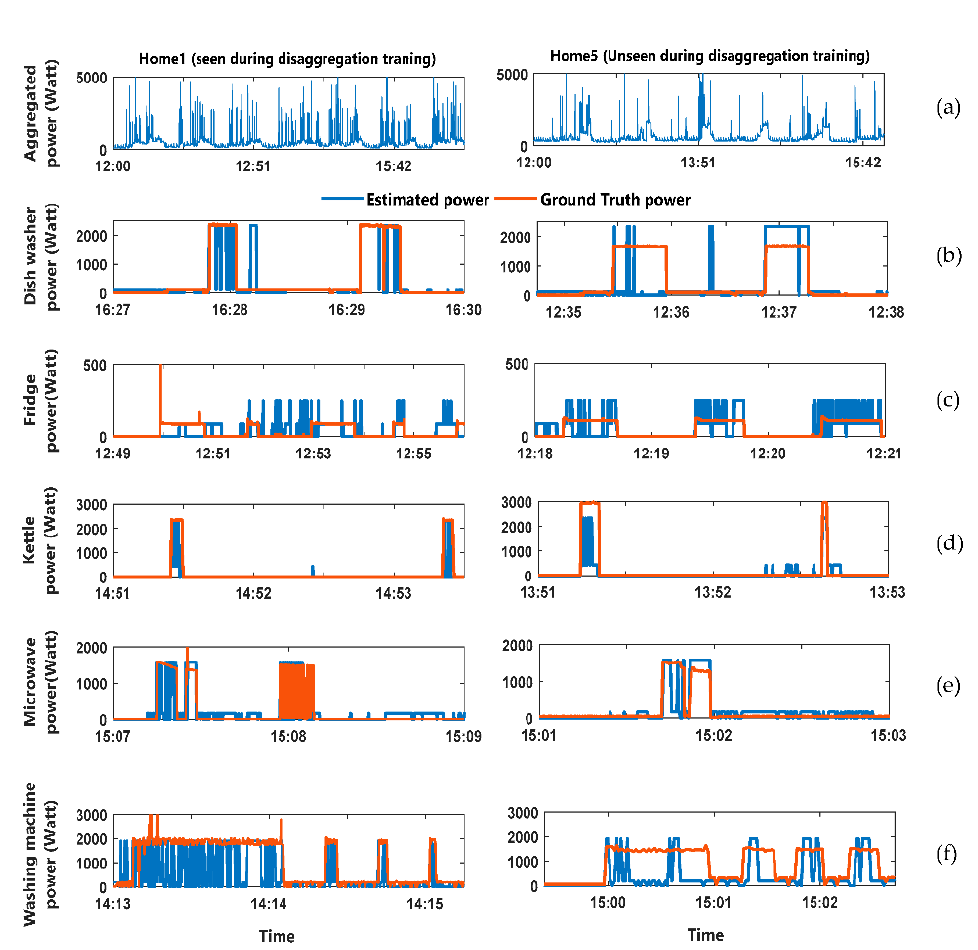
Figure 2. Shows the energy disaggregation algorithm output by using CO technique. ( a ) Aggregated power consumption for the home; ( b ) dishwasher estimated and Ground truth power demand; ( c ) fridge estimated and Ground truth power demand; ( d ) kettle estimated and Ground truth